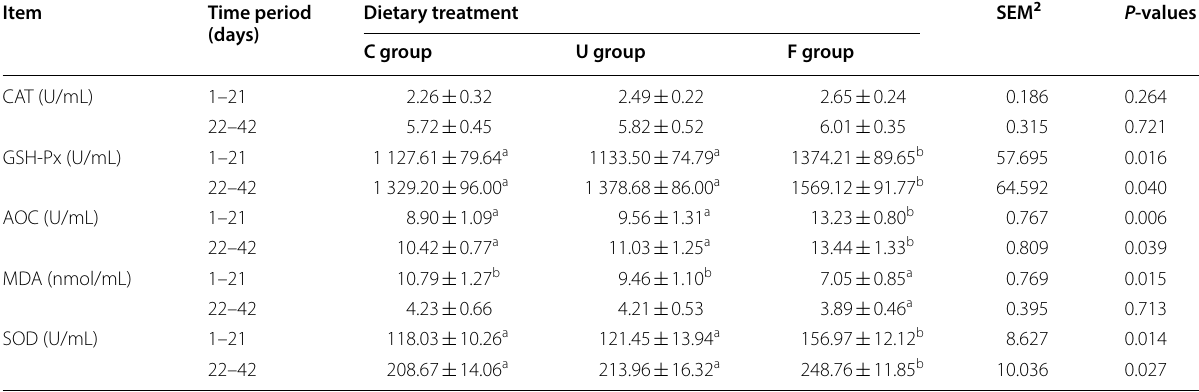
C group basal diet; U group basal diet 0.5% unfermented Astragalus ; F group = = + CAT catalase, GSH-Px glutathione superoxide dismutase, AOC antioxidant capacity, MDA malondialdehyde, SOD suproxide dismutase a,b Means in the same row bearing different superscripts differ significantly ( P